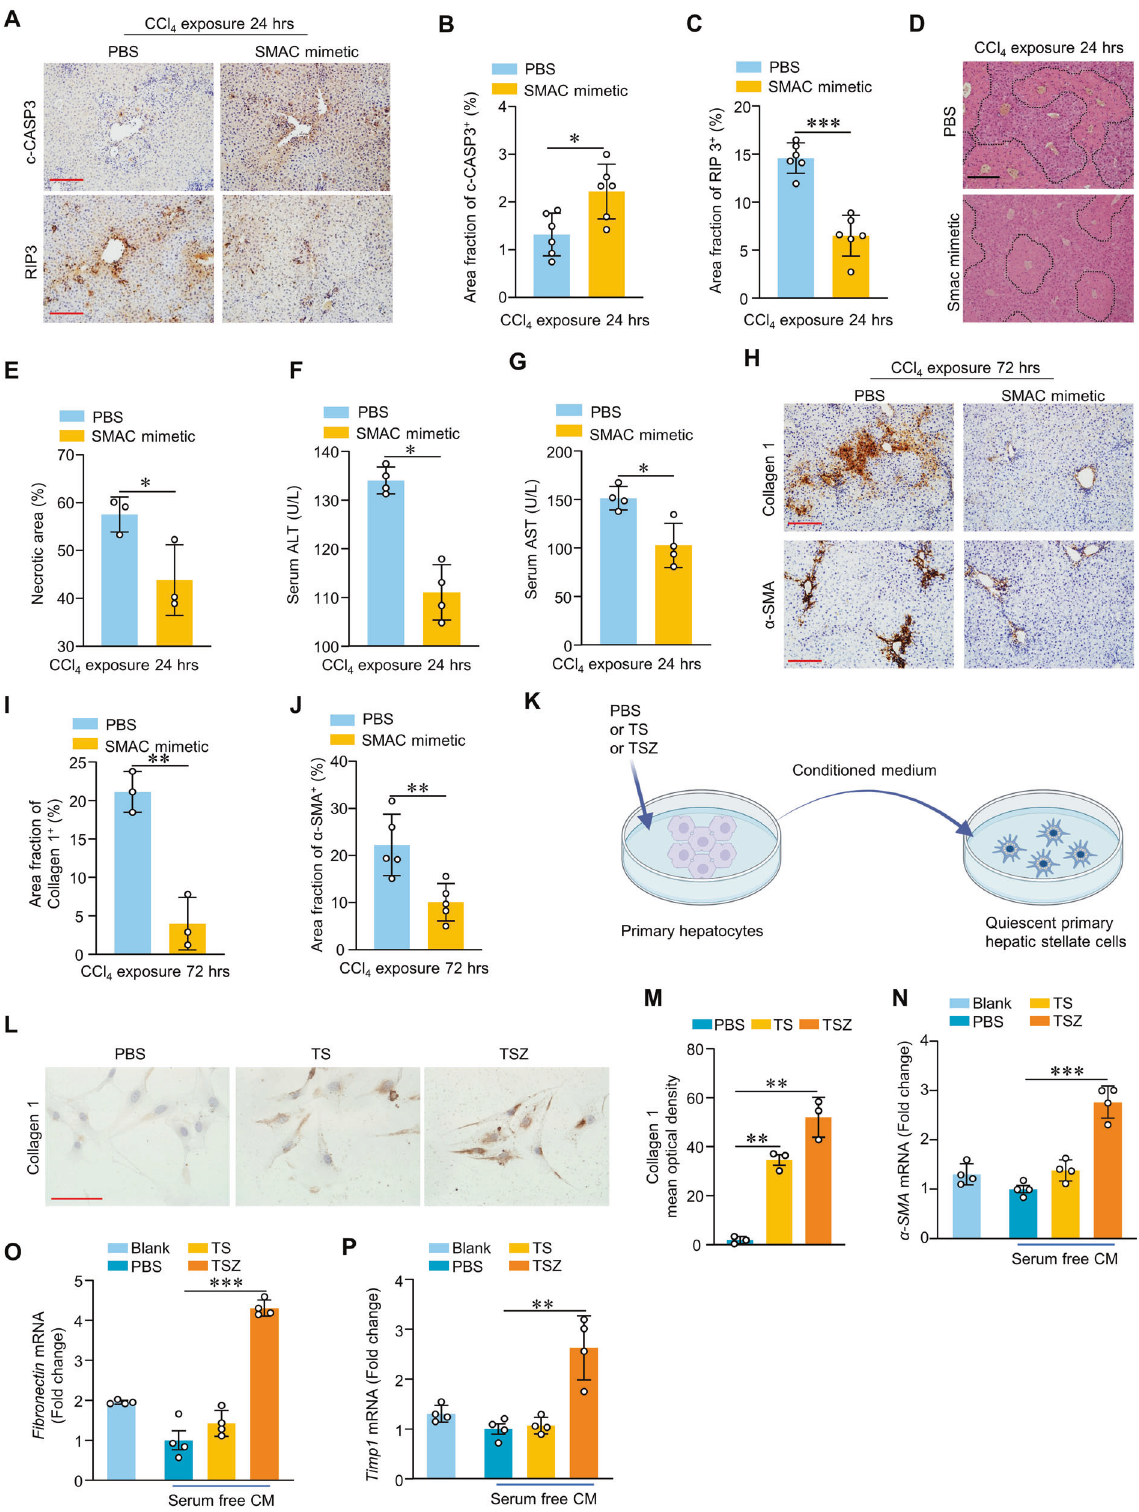
of apoptosis in tumors and normal organs [10]. As the most important catalytic subunit, PP2Ac α has also been shown to function in liver regeneration post-hepatectomy: it regulates the termination of regeneration processes via the AKT/GSK3 β /cyclin D1 signaling pathway